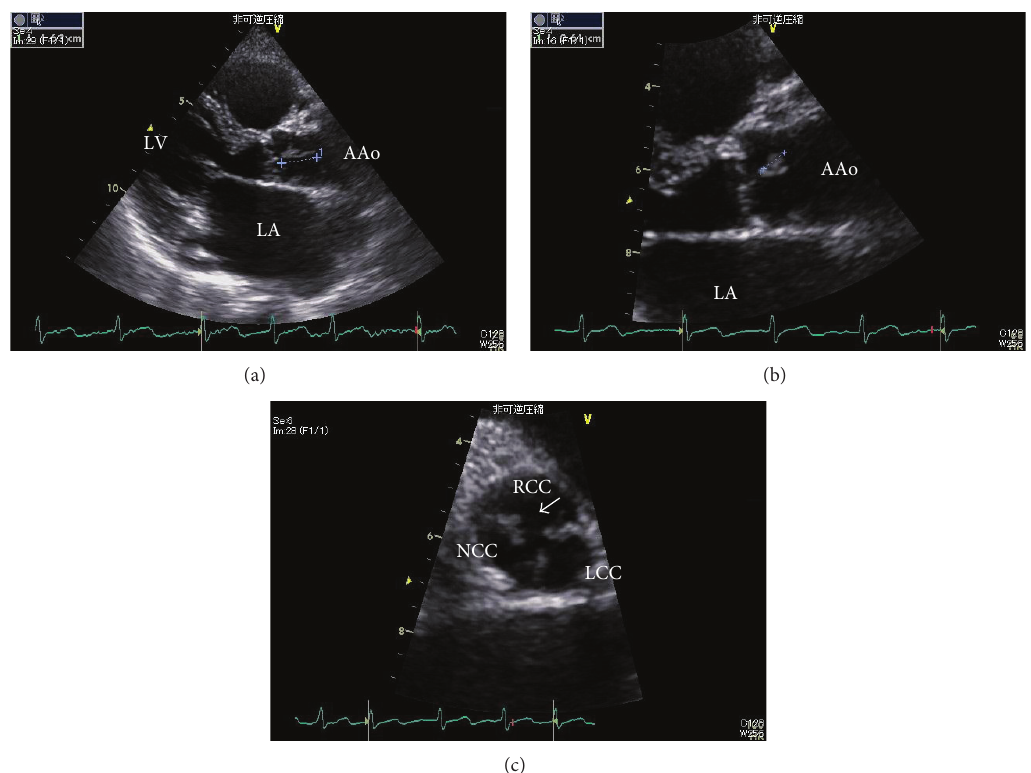
F 1: Transthoracic echocardiography. Transthoracic echocardiography revealed a mobile, string-like mass 7mm in size attached to the noncoronary cusp. (a) and (b) le parasternal short axis views, (c) le parasternal short axis view at the level of aortic valve.